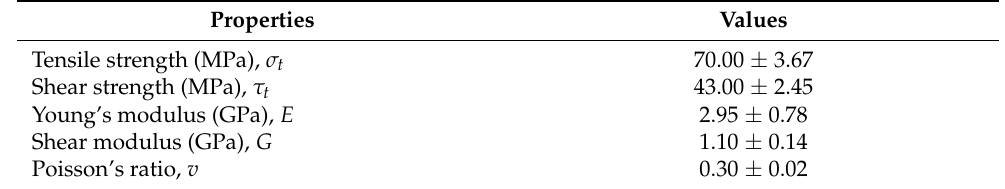
Figure 1. The dimension of ICB specimen. Table 1. Mechanical properties of PMMA used in this Table 1. Mechanical properties of PMMA used in this study.